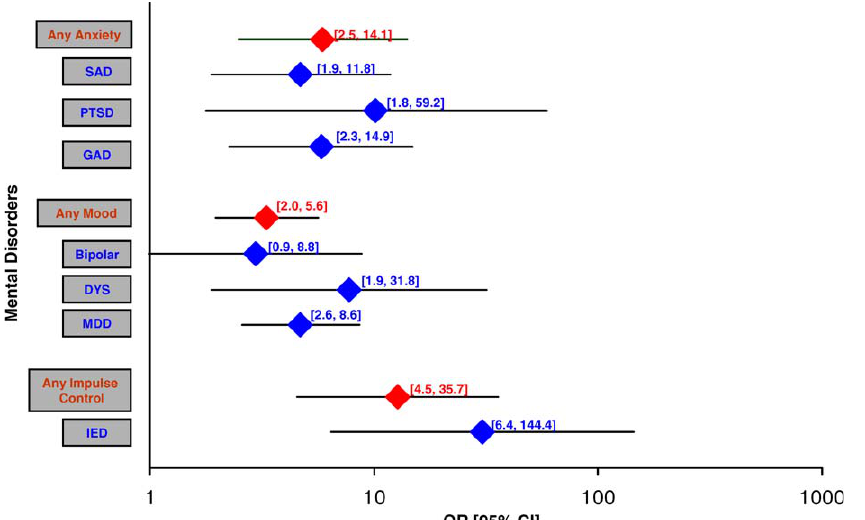
Figure 1. Effect of Cumulative War Trauma on First Onset of Psychiatric Disorders Disorders with number of cases too small ( n (cid:3) 30) were not included in this analysis. Odds ratios (diamonds) and 95% confidence intervals are plotted on a logarithmic scale. DYS, dysthymia; GAD, generalized anxiety disorder; IED, intermittent explosive disorder; MDD, major depressive disorder; SAD,